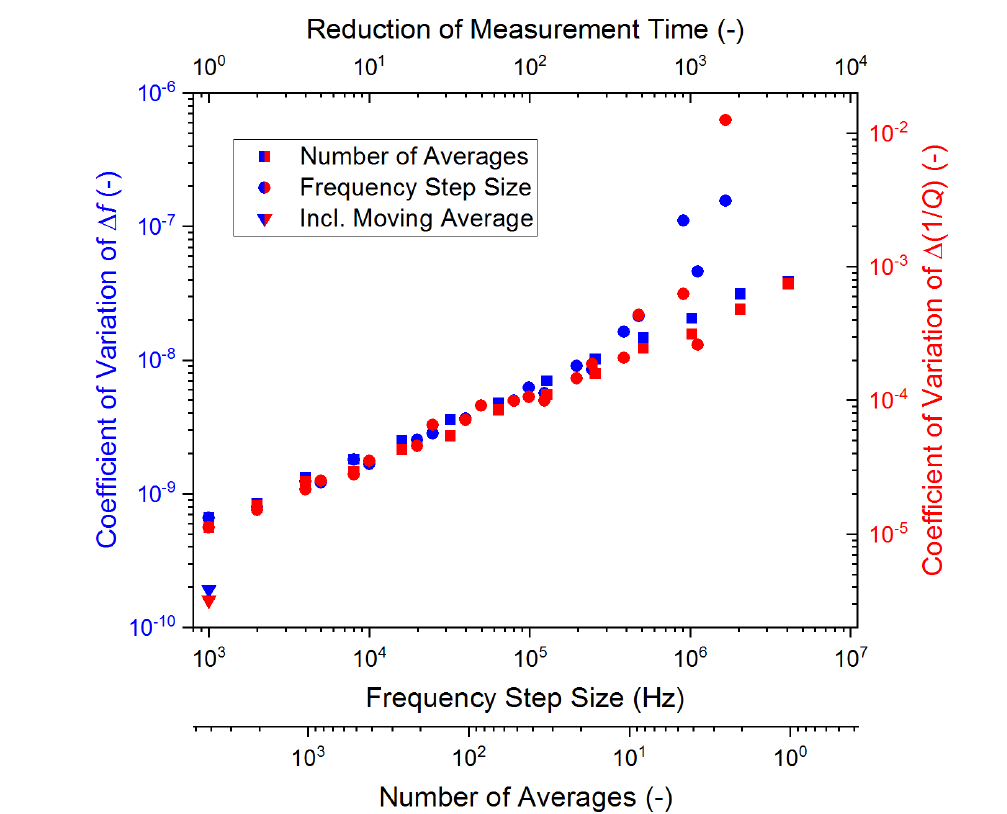
Figure 9. The coefficient of variation, i.e., the normalized standard deviation of ∆ ( 1/ Q ) (red) and ∆ f (blue) as a function of the number of averages (square) and the frequency step size (circle). The results indicated by triangular symbols show the effect of averaging 20 consecutive time